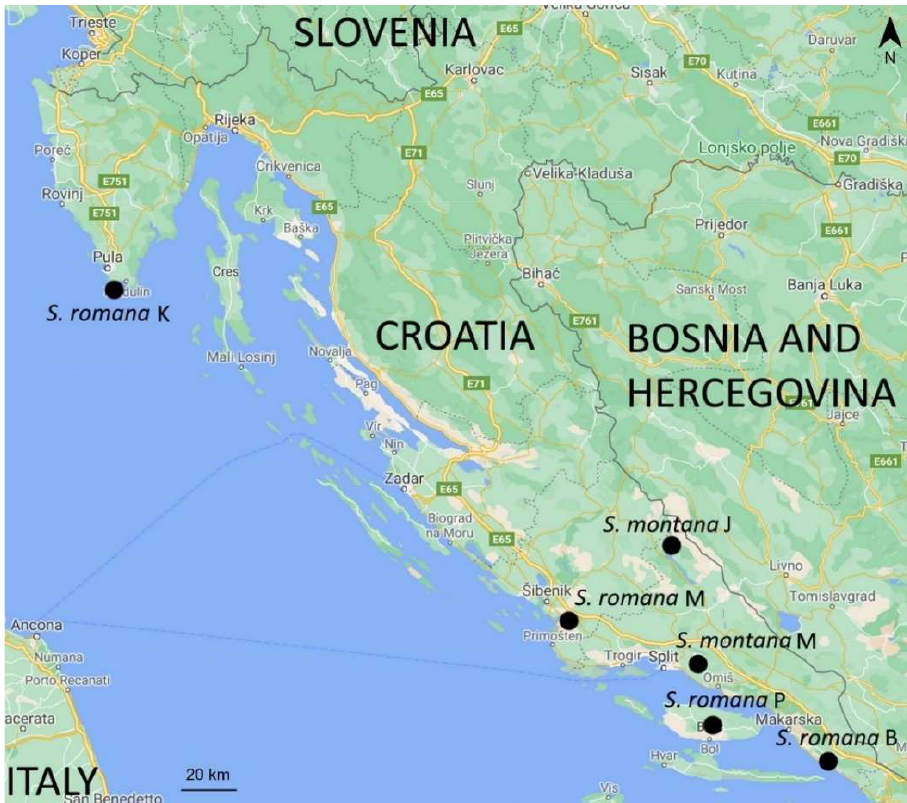
Figure 5. Harvesting locations for investigated Sideritis species.